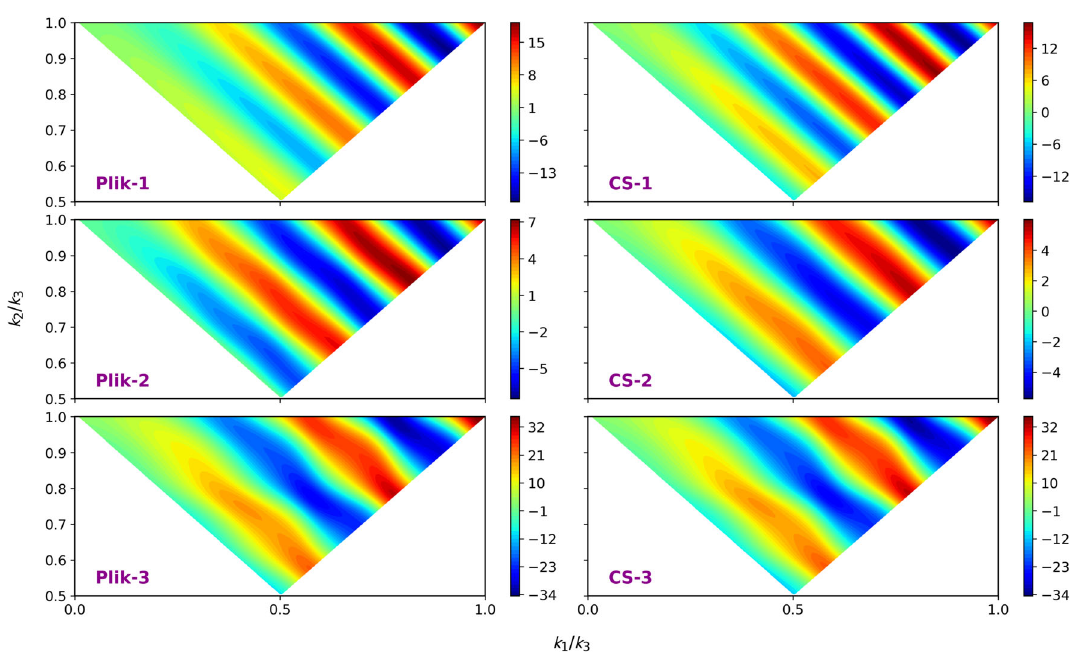
Fig. 11 2D heat map of f NL ( k 1 / k 3 , k 2 / k 3 ) for the best-fit candidates to the Plik-bin1 (left side) and CamSpec clean (right side) likelihood. f NL values are given in the color bar. Here k 3 is the mode which gave the maximum f NL in the equilateral limit for the corresponding candidate described in Sect. 3.2 and substitute in Eq. 32. Figure 9 dis- plays the f NL for all six candidates in the equilateral